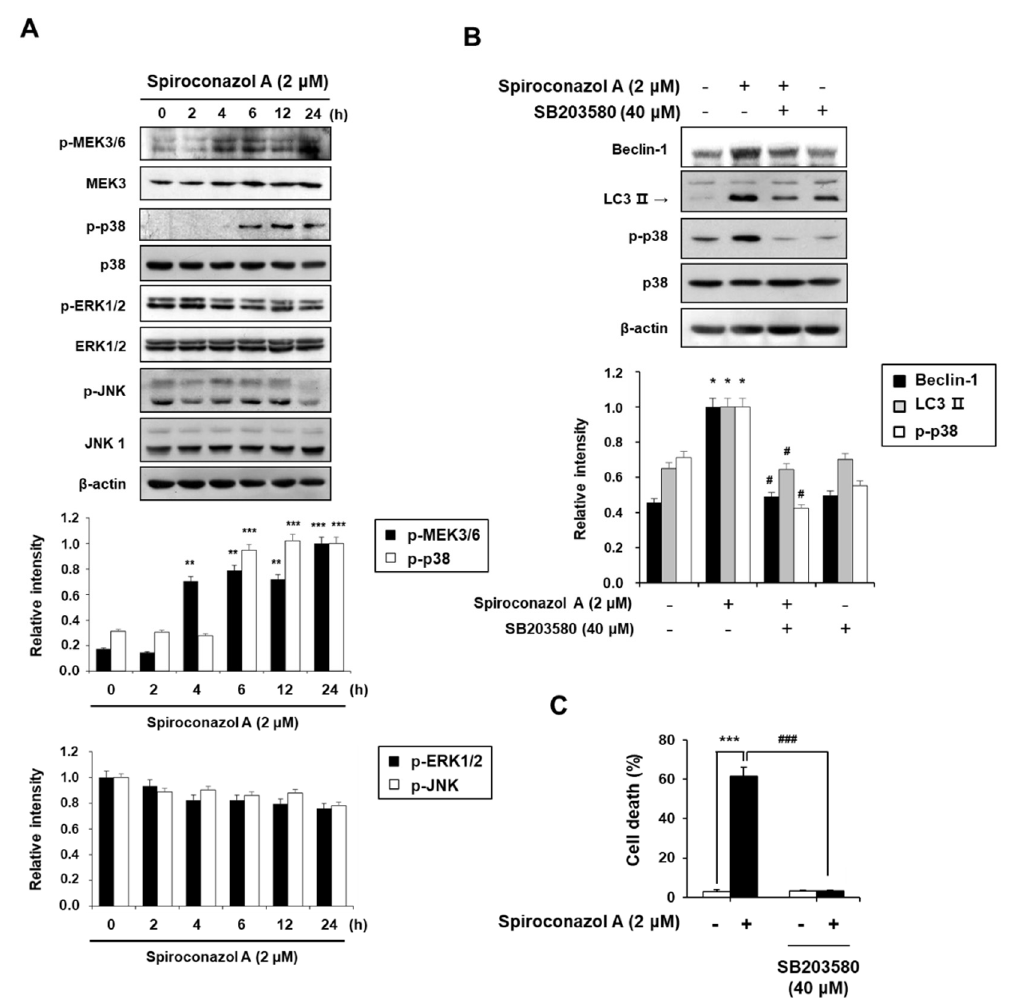
Figure 4. The p38 MAPK kinase signaling pathway is required in spiroconazol A-induced autophagic cell death. ( A ) After treatment with 2 μ M of spiroconazol A for the indicated times, cells were examined by Western blot analysis. After pretreatment with 40 μ M of SB203580 (p38 MAPK inhibitor), cells were treated with spiroconazol A for 24 h and then examined by ( B ) Western blot analysis and ( C ) PI staining, respectively. Experiments were repeated at least three times, and data are expressed as mean ± S.D. The relative optical density ratio was determined using a densitometric analysis program (Bio-Rad Quantity One ® Software, version 4.6.3 (Basic), Bio-Rad Laboratories Inc., CA, USA), normalized to the internal control. * p < 0.05, ** p < 0.01, *** p < 0.001 vs. untreated A549 cells and # p < 0.05, ### p < 0.001 vs. spiroconazol A-treated A549 cells, by the Student’s t -test.